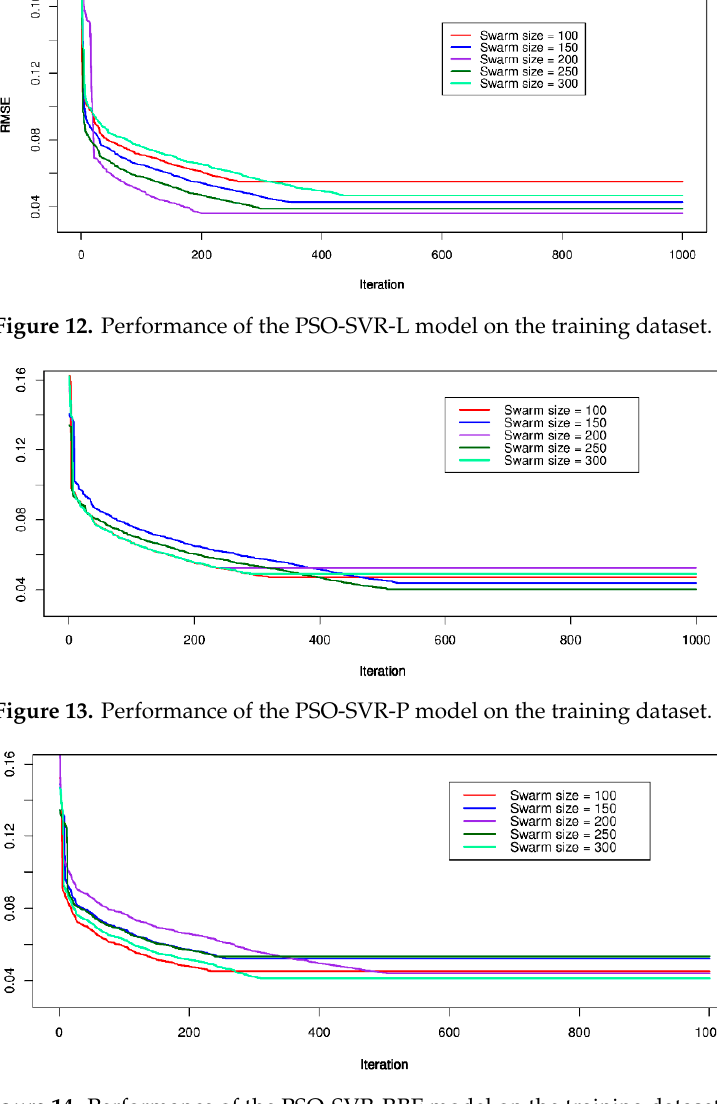
Figure 14. Performance of the PSO-SVR-RBF model on the training dataset.